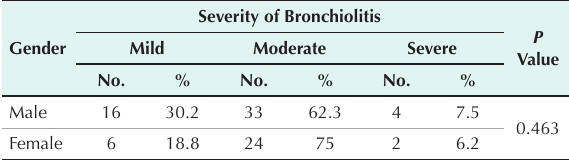
Table 3. Comparison of Mean Age Based on Bronchiolitis Severity and Vitamin D Status Variable Sub-group Severity of bronchiolitis